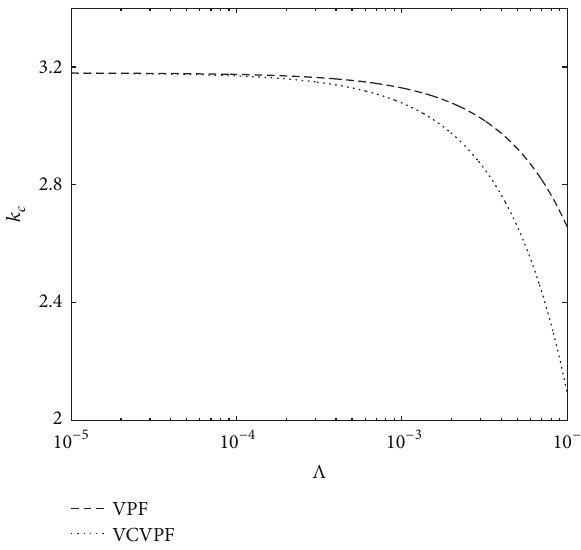
Figure 4: Comparison between the neutral curves for critical wave number obtained for VPF as well as VCVPF analysis when